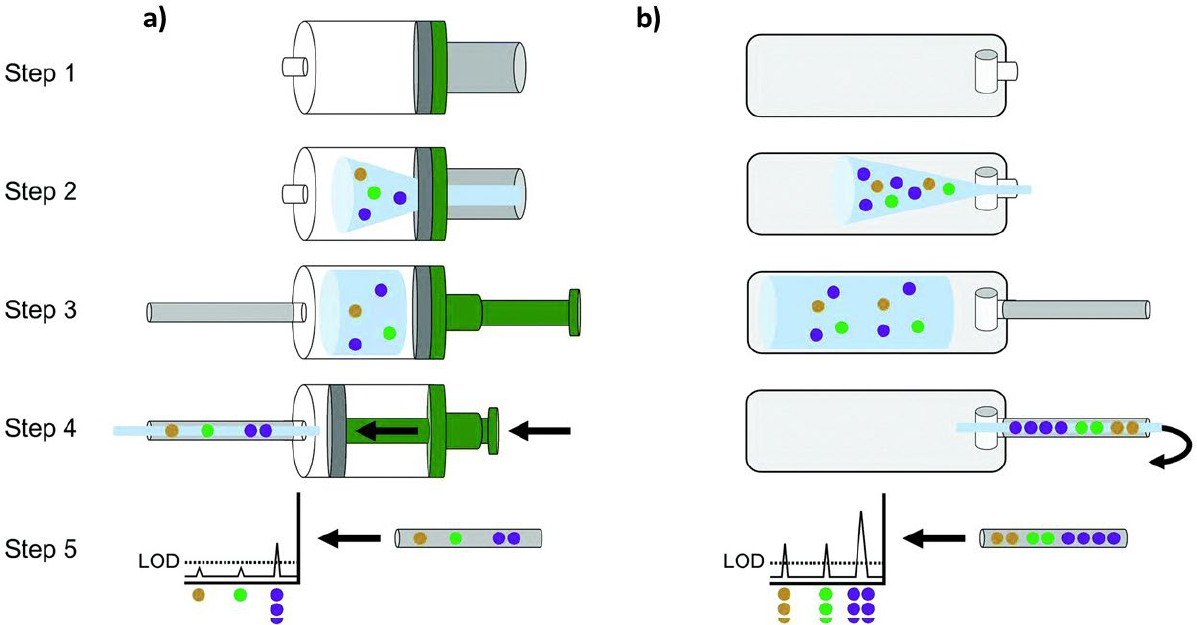
Figure 5. Comparison between paediatric ( a ) alveolar breath collection (via Bio-VOC™) and ( b ) total breath sampling (plastic bag). Step 1: the empty collection device. Step 2: patient exhales into the collection device. Different colour dots represent different VOCs. Step 3: Sorbent tube is affixed to the collection device. Step 4: Breath volume driven through the sorbent tube by depressing plunger or using an air pump. VOCs are captured on the sorbent tube. Step 5: VOCs are released from the sorbent tube by thermal desorption and measured by GC/MS. LOD: Limit of detection. Overall, the total breath sampling bag collects a larger volume of breath (Step 3) leading to a greater quantity of breath VOCs captured. This in turn is reflected as higher signals by GC/MS, including multiple breath VOCs that were undetectable via the alveolar breath collector Bio-VOC™ (Step 5). Adapted from ref [69] with permission from the Royal Society of Chemistry.